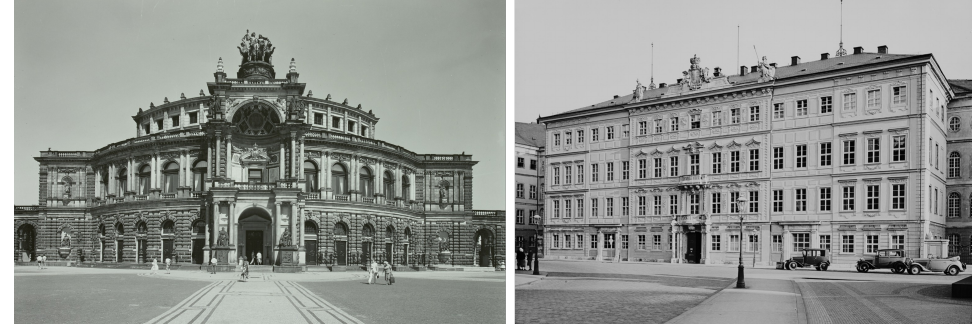
Figure 3. Query images used for the Semperoper ( left ) and Taschenbergpalais ( right